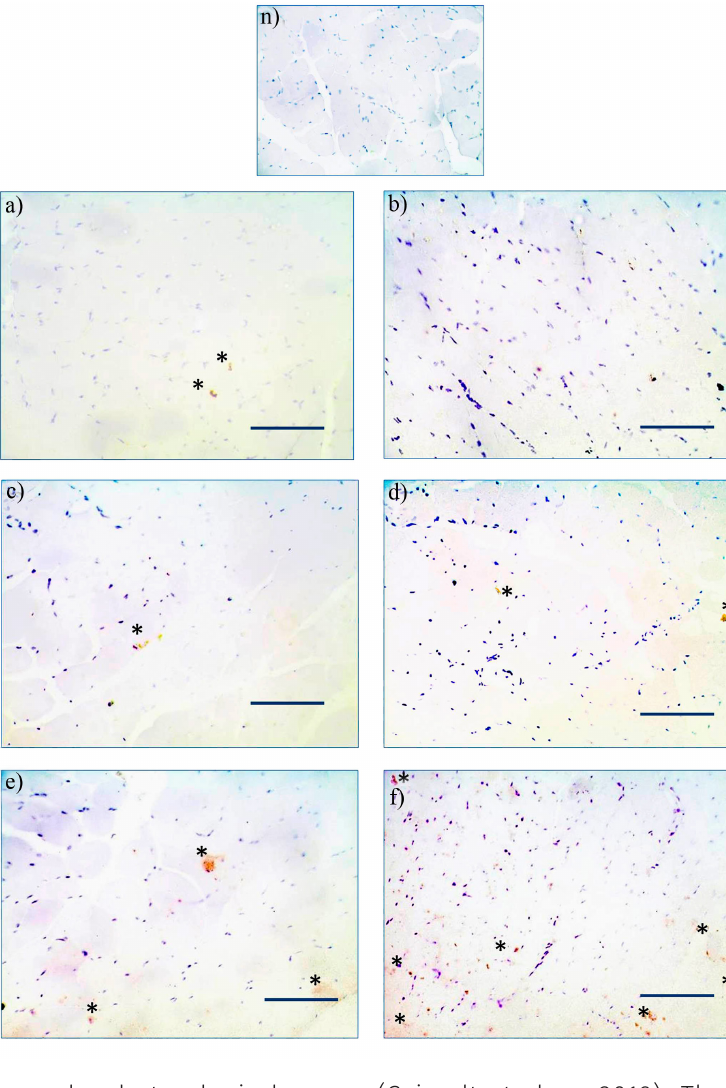
Figure 13. Immunohistochemical analysis of anti-HSP70 in muscle tissue of right tibialis anterior of mdx mice treated with different doses of aqueous extract from leaves of Miconia ferruginata (Photomicrography, 1:500 dilution). n) control negative of reaction; a) control group; b) 50 mg kg -1 group;